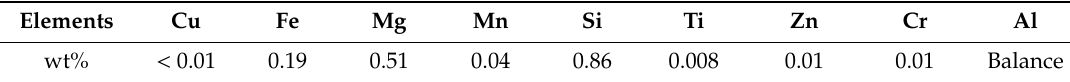
Table 1. Chemical composition of tested AA6063 in wt% [16].